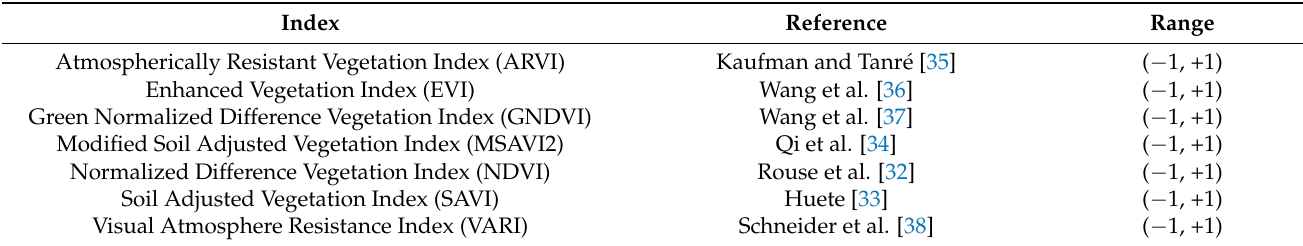
Table 2. Vegetation indices used in the present